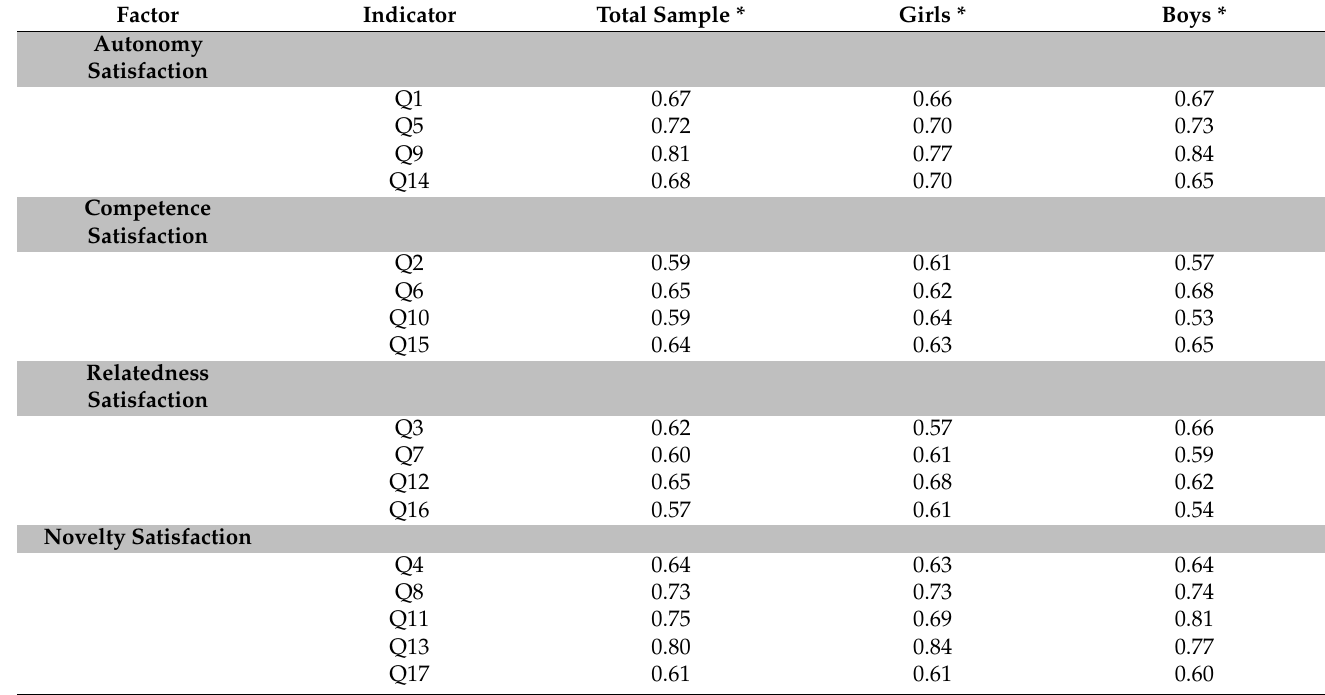
Table 5. Factorial loadings of the BPN-CS by sub-scale and gender.